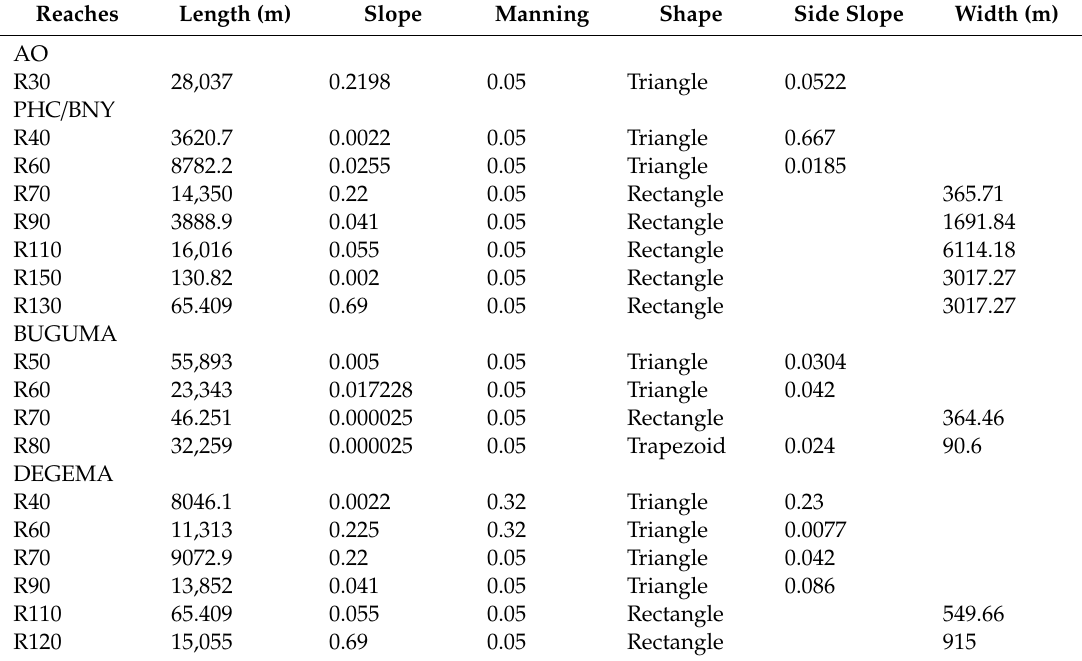
Table 2. Channel geometry data comprising of channel slope, roughness (Manning’s n), channel shape, side slope and channel width